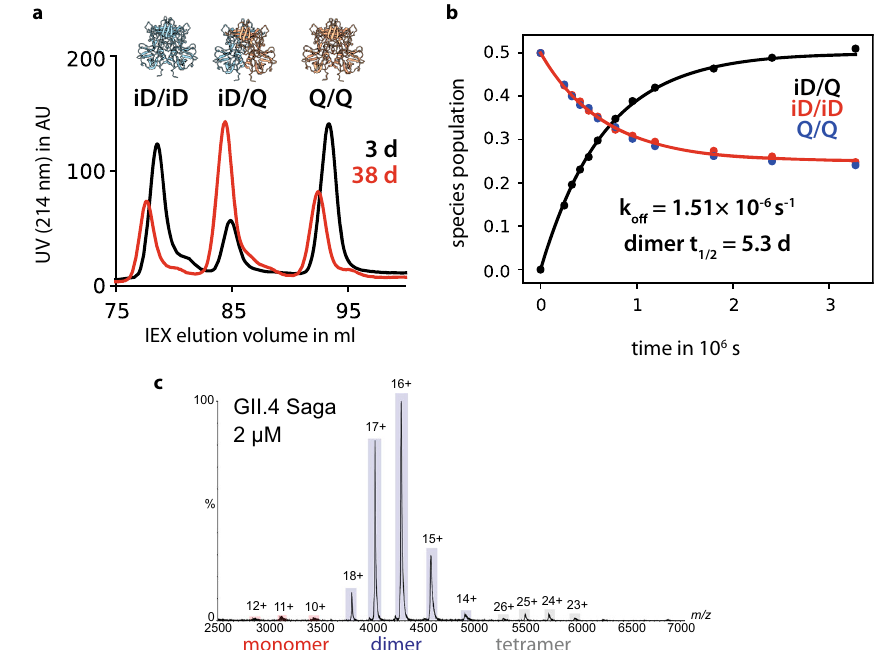
Fig. 2 Dimer exchange kinetics of human NoV GII.4 Saga. a P-domain samples which were deamidated at position 373 into a negatively charged iso- aspartate (iD) residue and point mutants with a neutral Gln at this position were mixed 1:1 and incubated at 298 K. The fraction of mixed 373iD/Q dimers was quanti fi ed by analytical ion-exchange chromatography at selected time intervals. Homo- and mixed dimer fractions reached the expected 1:2:1 ratio after ~40 d. b Curve fi tting yields a k off of 1.5 ± 0.02 × 10 − 6 s − 1 , corresponding to a dimer half-life time of 5.3 d. c Native mass spectra of human NoV GII.4 Saga P-domain (N/N P-dimers) con fi rm mostly dimeric stoichiometry even at low protein concentration. ba